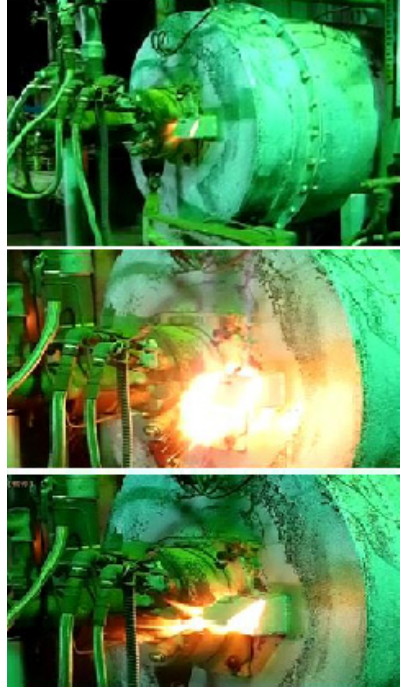
Figure 4. Photographs of instability during the combustion test.